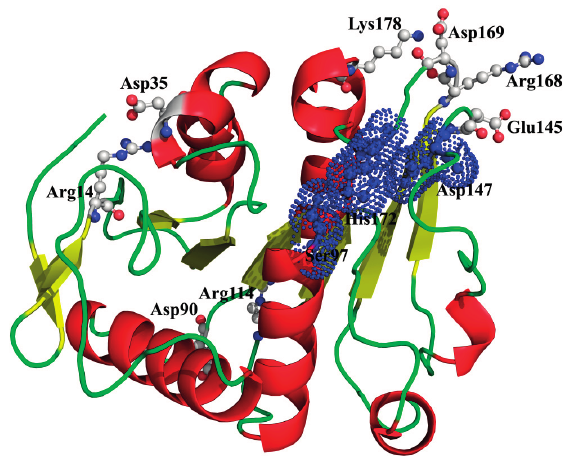
Figure 9. The spatial distribution of the important salt bridges in P186_1588. The backbone of the protein is represented in cartoon. Residues forming the ion pairs are represented in ball-and-stick mode. The catalytic residues (Ser 97 , Glu 147 and His 172 ) were shown as